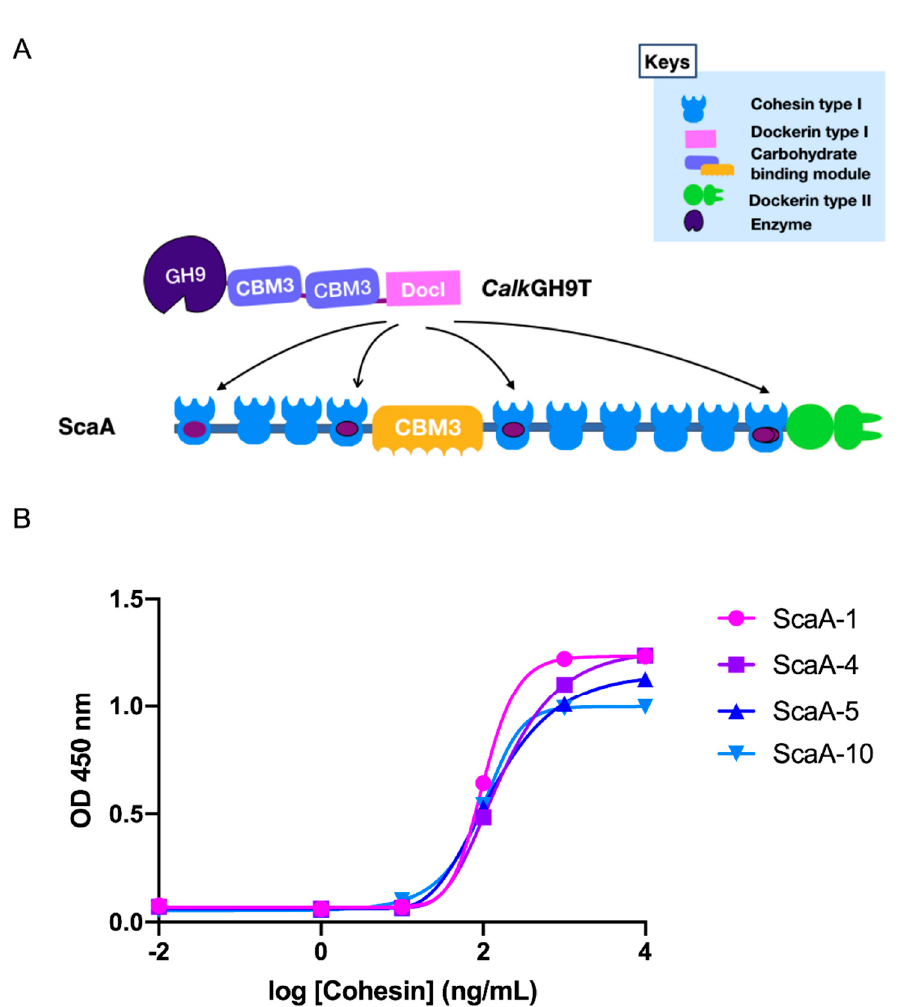
Figure 6. Binding interaction of the type I dockerin of Calk GH9T and the cohesins modules of the primary scaffold ScaA of C. alkalicellulosi cellulosome. ( A ) Schematic representation of Calk GH9T showing a modular architecture and ScaA containing 10 cohesin modules. Dots indicate the cohesin modules that were expressed for affinity binding test. ( B ) Affinity-based ELISA profiles the dockerin towards different ScaA cohesin modules. ScaA-1, 4, 5, and 10 refer to of cohesin modules 1, 4, 5, and 10 of ScaA, and the designated numbers of the cohesin modules begin from the cohesin at the N- terminus.